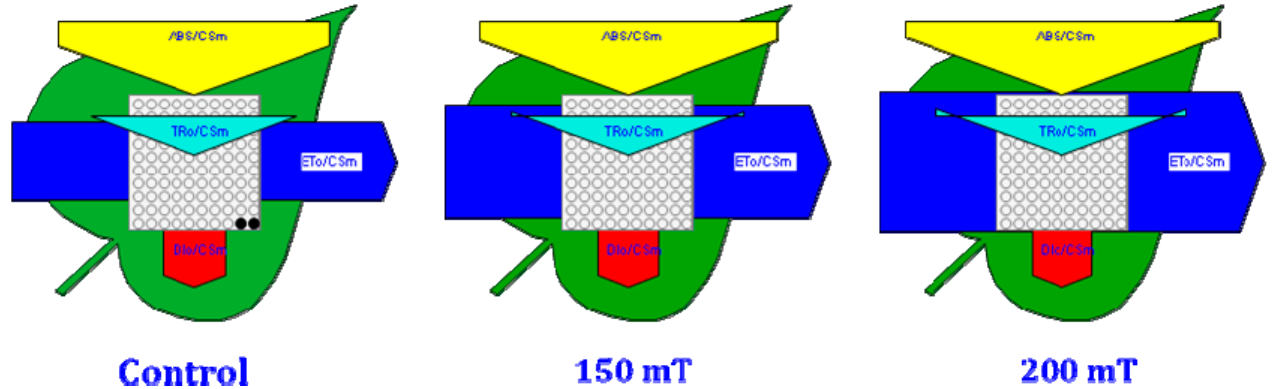
Figure 8. Phenomenological leaf model of soybean leaves demonstrating the effect of magnetic field treatment. Each relative value is represented by the size of the proper parameters (arrow), empty circles represent reducing Q A reaction centres (active), and full black circles represent non-reducing Q A reaction centres (inactive or silent).